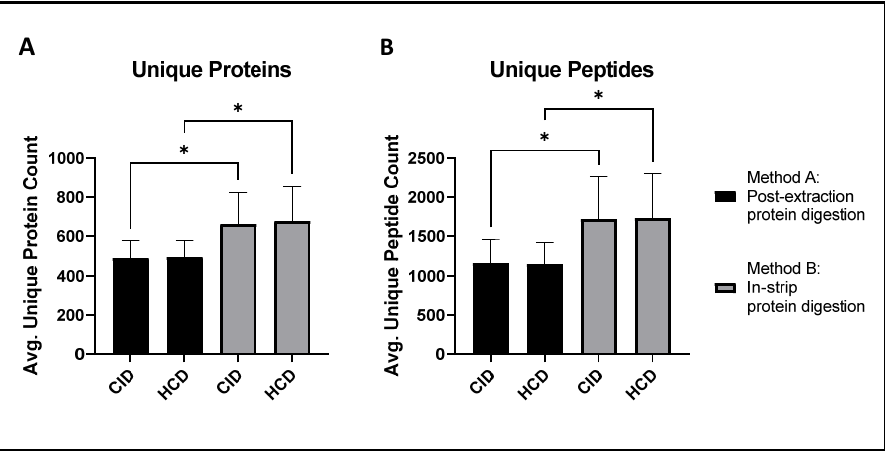
Figure 2. In-strip protein digestion (Method B) provides a significant increase in both protein and peptide yield compared to post-extraction protein digestion (Method A) in tear fluid samples. The average protein and peptide counts per sample identified in all four workflows were compared via two-way ANOVA with Tukey’s correction. ( A ) Method B identified more proteins than Method A when paired with both CID and HCD fragmentation. ( B ) In-strip protein digestion also identified more peptides than post-extraction digestion following both CID and HCD fragmentation. Results are expressed as means ± SD; n = 11/group; * p -value <0.05.